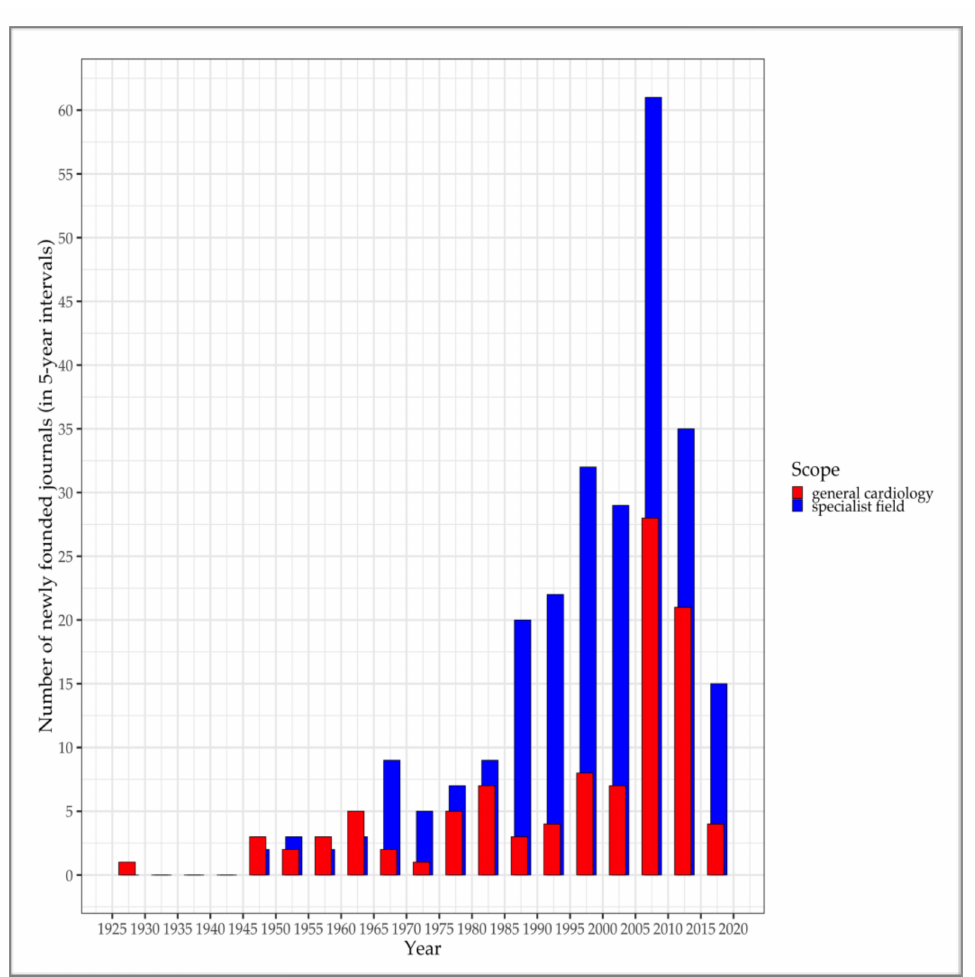
Figure 2. New foundations of cardiological journals between 1925 and 2018. Source: authors’ own compilation based on dataset from Scimago Journal and Country Rank